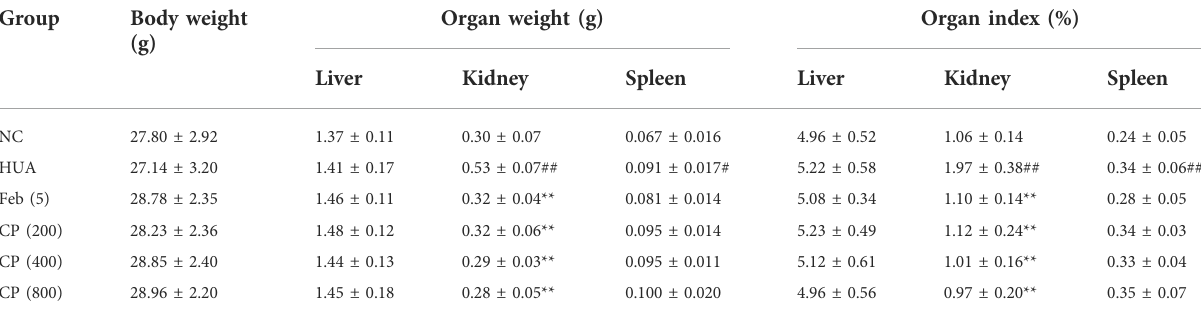
TABLE 5 Effect of CP on body weight, organ weight and organ index. Group Body weight Organ weight (g) Organ index (g)